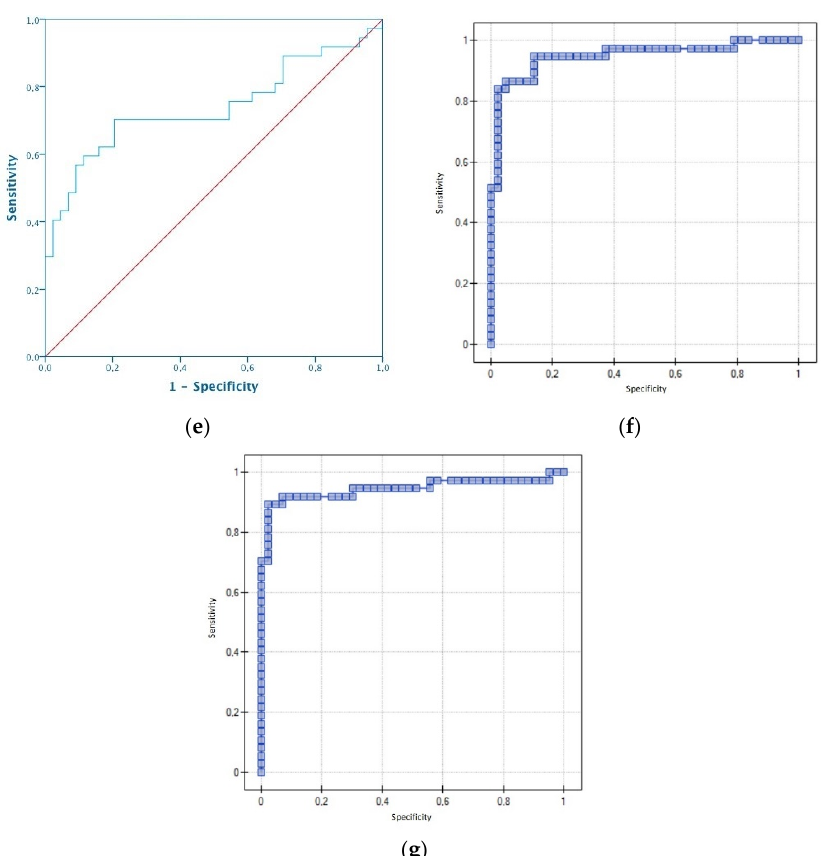
Figure 1. Receiver operating characteristic curve for using ( a ) BTLA, ( b ) CD27, ( c ) CD70, ( d ) CD28, ( e ) CD80, ( f ) CA125 and ( g ) HE4 in distinguishing between ovarian cancer and benign ovarian lesions.